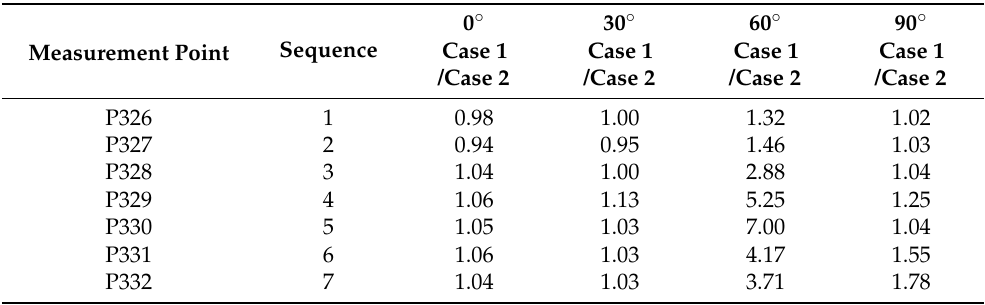
Table 2. Ratio of maximum values of wind pressure coefficients at measurement points under different